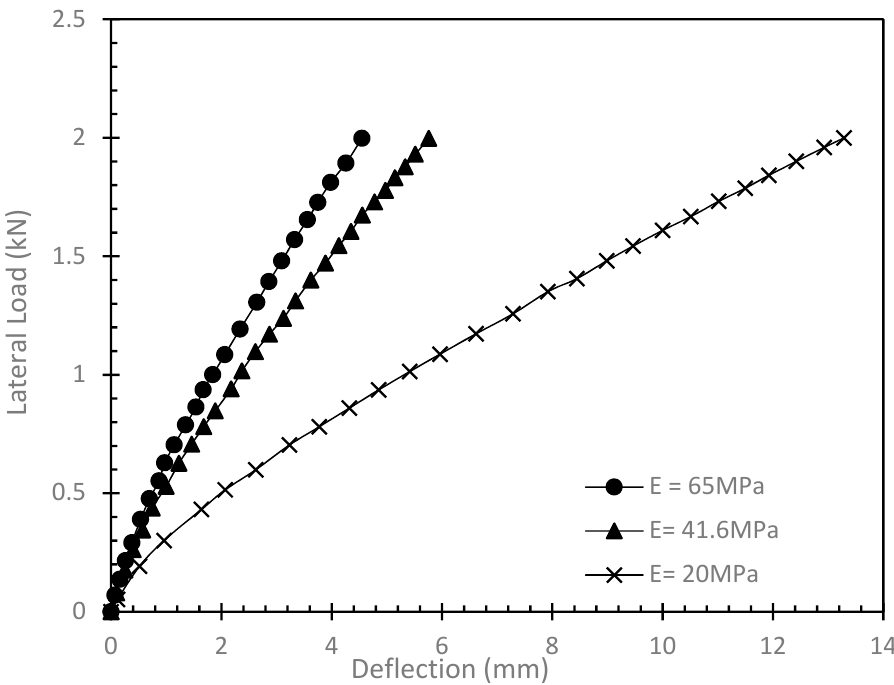
Figure 20. Effect of the Young’s modulus of sand under a lateral load on CFRP pile deflection.